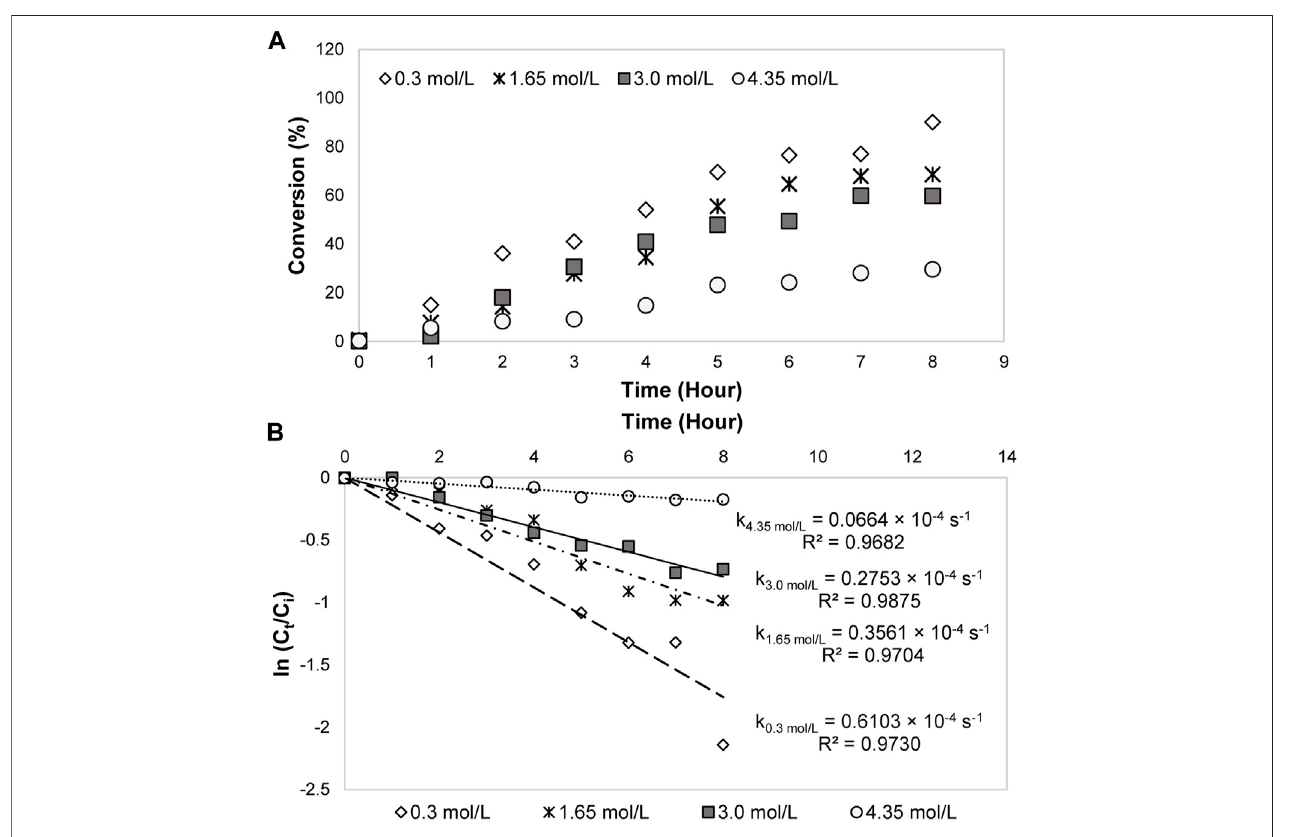
FIGURE 7 | (A) Glycerol conversion and (B) fi rst-order kinetics model for electrocatalytic reduction of glycerol with different initial concentrations.